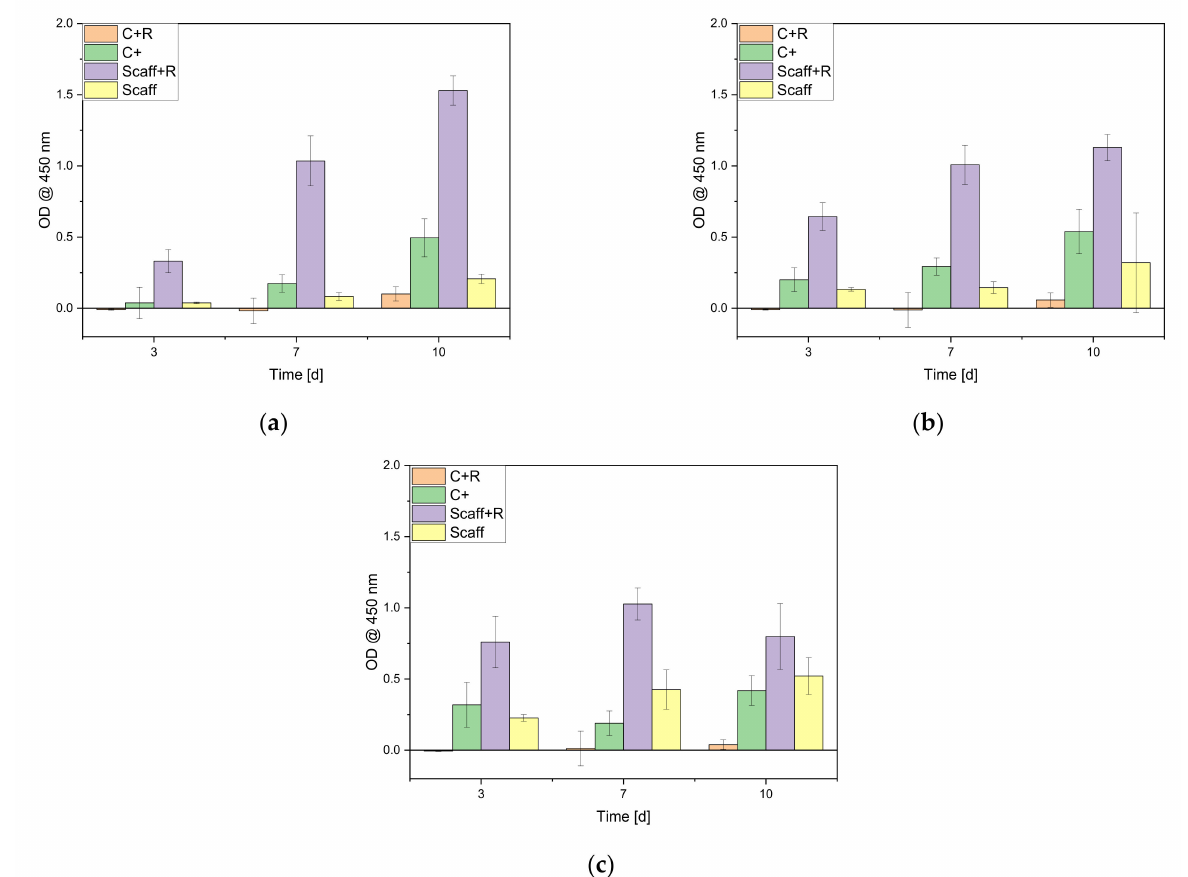
Figure 7. Overview over the cell proliferation assays for the 3 different cell types; ( a ): MG-63; ( b ): MLO-Y4; ( c ): MSC; C + = Positive control/cells on Thermanox, Scaff = Cells on scaffold; C + R = remaining cells in the control cell culture plate, Scaff + R = Remaining cells in the TCP sample cell culture